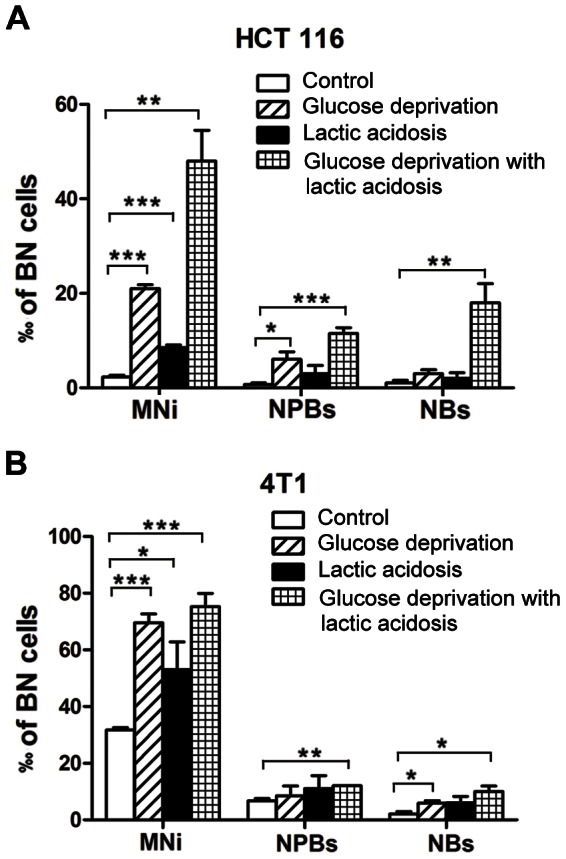
The effect of lactic acidosis, glucose deprivation, and lactic acidosis with glucose deprivation on chromosome instability.(A) The numbers of HCT116 cells that carry MNi, or NPBs, or NBs in every 1000 BN cells. *p<0.05, **p<0.01, *** p<0.005. HCT116 cells were cultured in 4 different conditions: condition 1 (control), regular RPMI-1640; condition 2 (glucose deprivation), RPMI-1640 containing 0.5 mM glucose; condition 3 (lactic acidosis), regular RPMI-1640 with 20 mM lactic acidosis. To avoid glucose deprivation during 7-day culture, we replaced the medium every 2 days; condition 4 (glucose deprivation with lactic acidosis), RPMI-1640 containing 0.5 mM glucose with 20 mM lactic acidosis. Cells were harvested at the indicated time and subjected for analysis of MNi, or NPBs, or NBs. (B) The numbers of 4T1 cells that carry MNi, or NPBs, or NBs in every 1000 BN cells. *p<0.05, **p<0.01, *** p<0.005, in comparison to control. 4T1 cells were cultured in 4 different condition as described in (A) except condition 2 and 4 in which glucose was 3 mM.